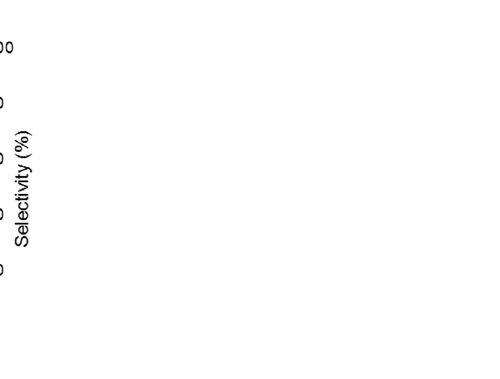
Figure 5. Effect of initial pH on ammonia conversion of NH 4 Cl and CH 3 COONH 4 solutions over Ru-Cu/C catalyst. Conditions: [NH